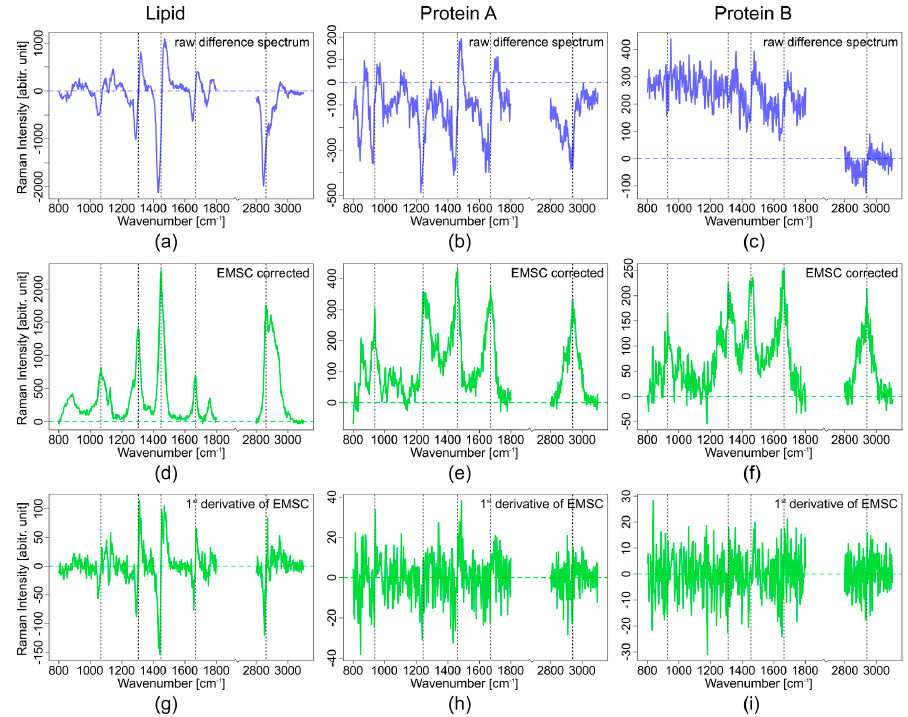
Figure 5. Comparison of measured lipid spectrum ( a , d , g ) and two protein spectra ( b , e , h ) and ( c , f , i ). Raw SERDS difference spectra (2 nm shift, ( a – c ), blue); EMSC corrected spectra at 785 nm (( d – f ), green); 1st derivative of the EMSC corrected spectra at 785 nm (( g – i ), green); the vertical black lines mark band positions.